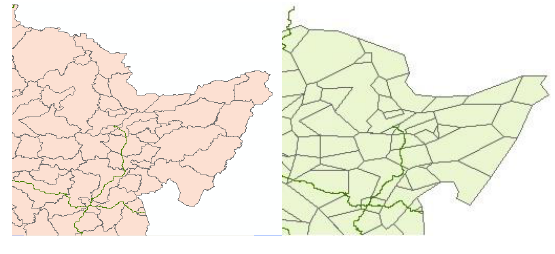
Figure 4. Simplify polygon